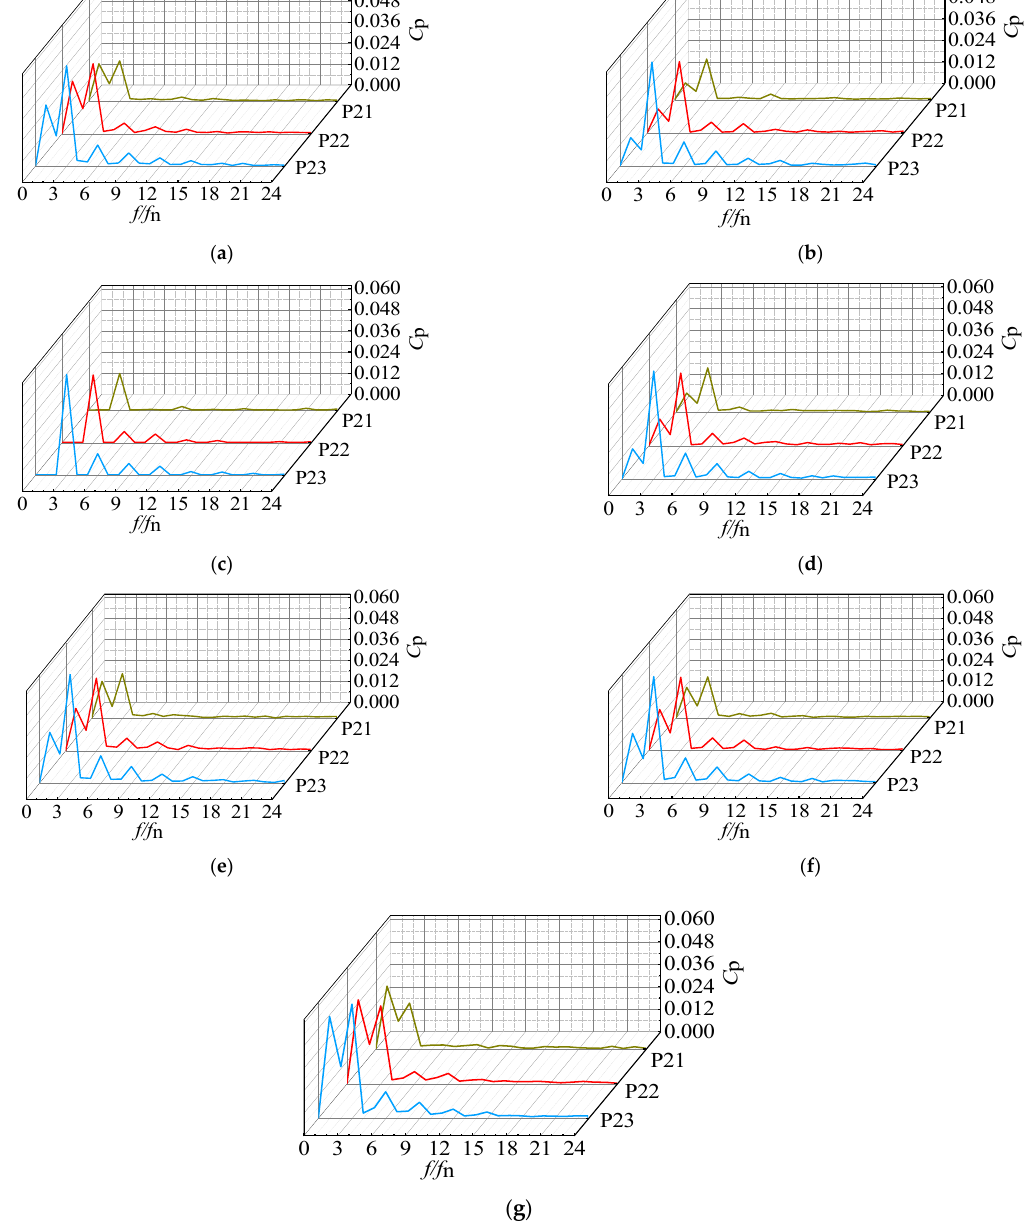
Figure 15. Frequency-domain diagrams of the pressure fluctuations at the impeller outlet: ( a ) Design Scheme I; ( b ) Design Scheme II; ( c ) Design Scheme III; ( d ) Design Scheme IV; ( e ) Design Scheme V; ( f ) Design Scheme VI; and ( g ) Design Scheme VII. Table 5. Amplitude of the dominant frequency at P2.